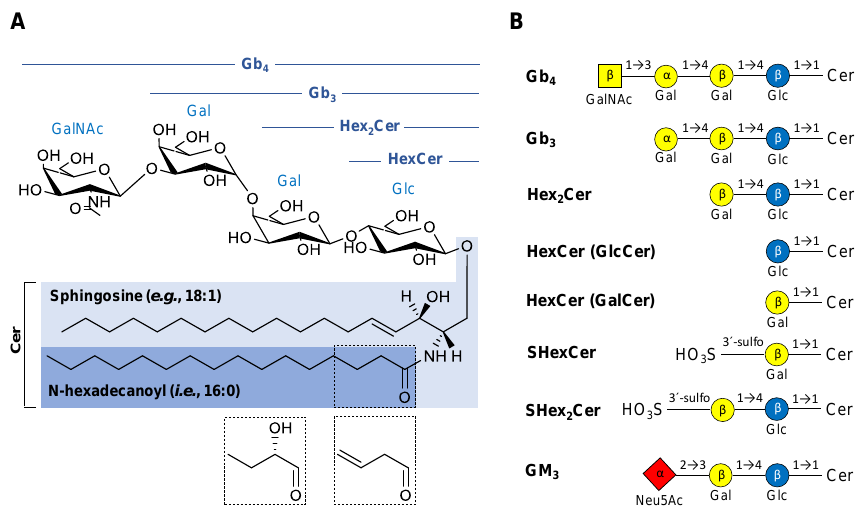
Figure 1. Overview of chemical structures of the neutral and acidic glycosphingolipid (GSL) subclasses studied in this work: ( A ) General structure of neutral GSL depicting individual parts of the complex molecule with possible modifications of N-linked fatty acyl chain (dashed boxes). ( B ) Basic structures of GSL subclasses using the established glycan symbols (the letter and the number within symbols define the nature of the glycosidic linkage). Abbreviations used in the figure are as follows: ceramides (Cer), N-acetylneuraminic acid (Neu5Ac), galactose (Gal), glucose (Glc), N-acetylgalactosamine (GalNAc), globotetraosylceramides (Gb 4 ), globotriaosylceramides (Gb 3 ), dihexosylceramide (Hex 2 Cer), monohexosylce- ramide (HexCer)—glucosylceramide (GlcCer) or galactosylceramide (GalCer), monohexosylsulfatide (SHexCer), dihexosyl- sulfatide (SHex 2 Cer), monosialodihexosylganglioside (GM 3